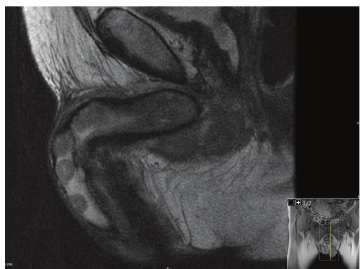
Figure 1: MRI showing low signal lesions invading the corpora cavernosa.